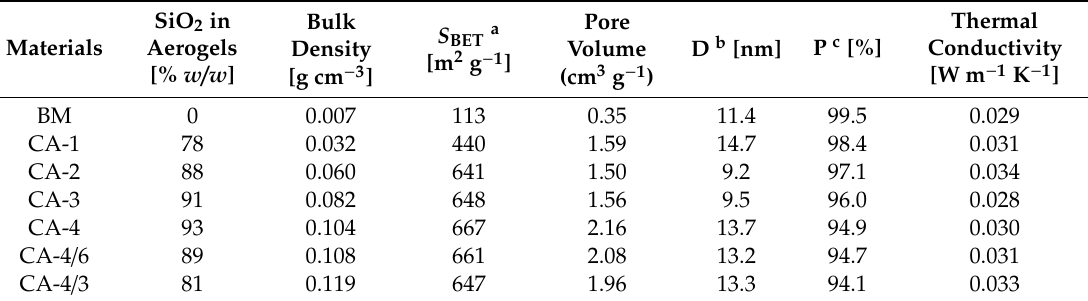
Table 1. Physical properties of the dried BC matrix (BM) and composite aerogels (CAs) with varying precursor